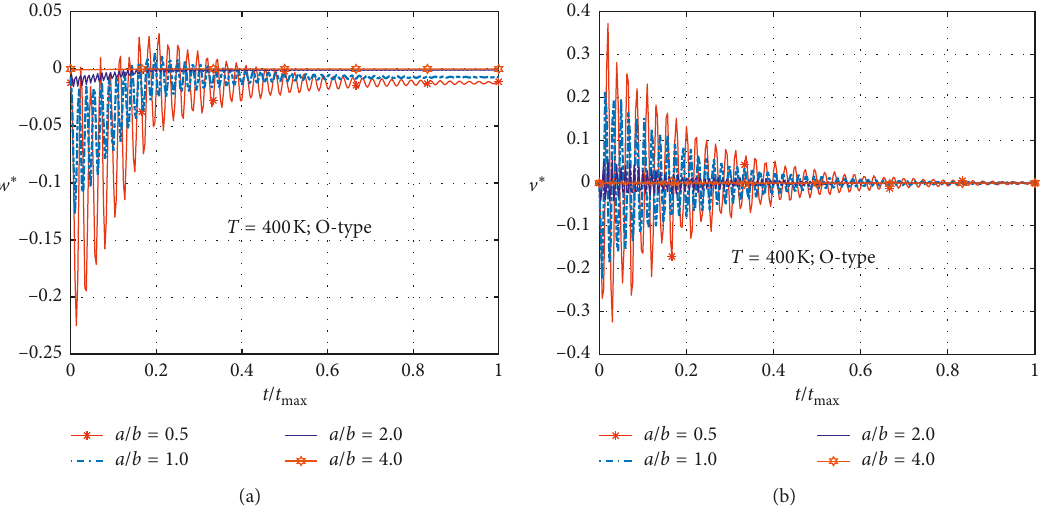
Figure 9: Influence of length-to-width ratio on nondimensional deflection, velocity, and stress of the centroid at T (a) deflection